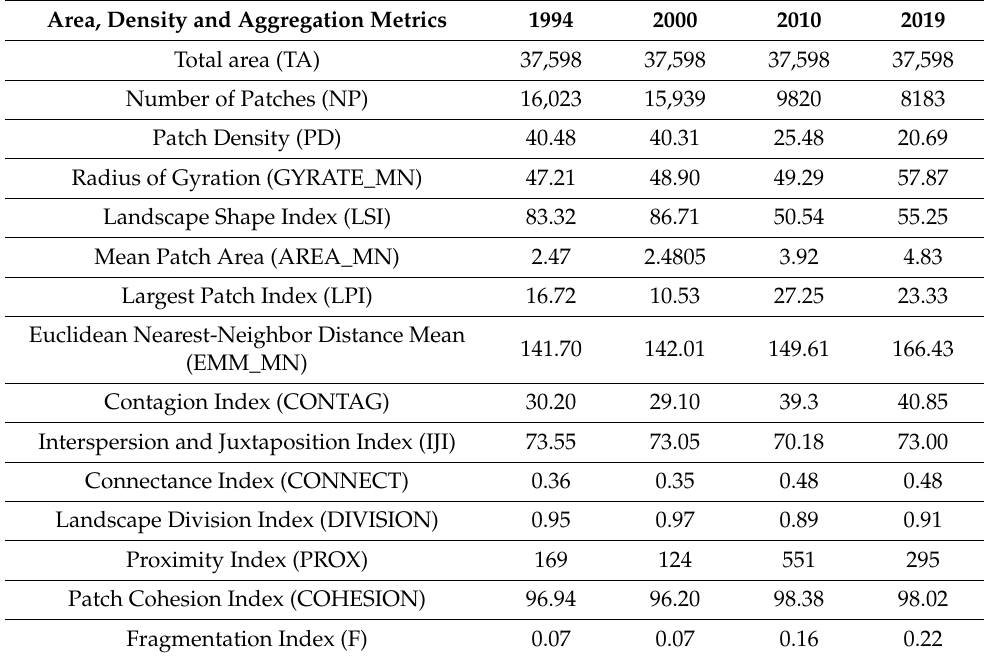
Table 6. Table of area, density and landscape aggregation metrics obtained by the FRAGSTAT soft- ware.